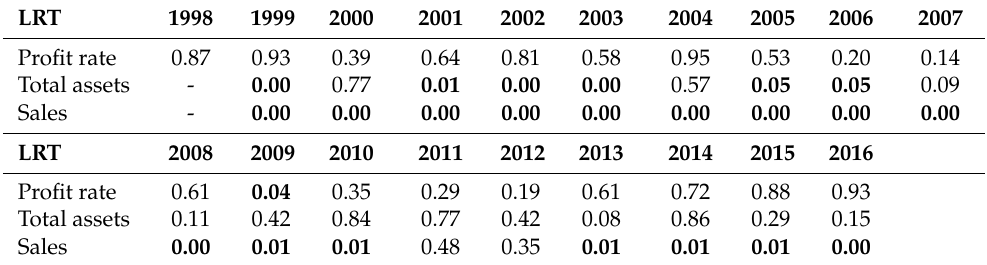
Table 1. P -values of the likelihood ratio test for profit and growth rates of total assets and sales. The null hypothesis is the Laplace distribution, while the alternative hypothesis is the Subbotin distribution. The results refer to the 200 largest long-lived firms, according to their sales in 2016, when deleting the extreme positive and negative value. In bold, we underlined P -values below 5%. LRT